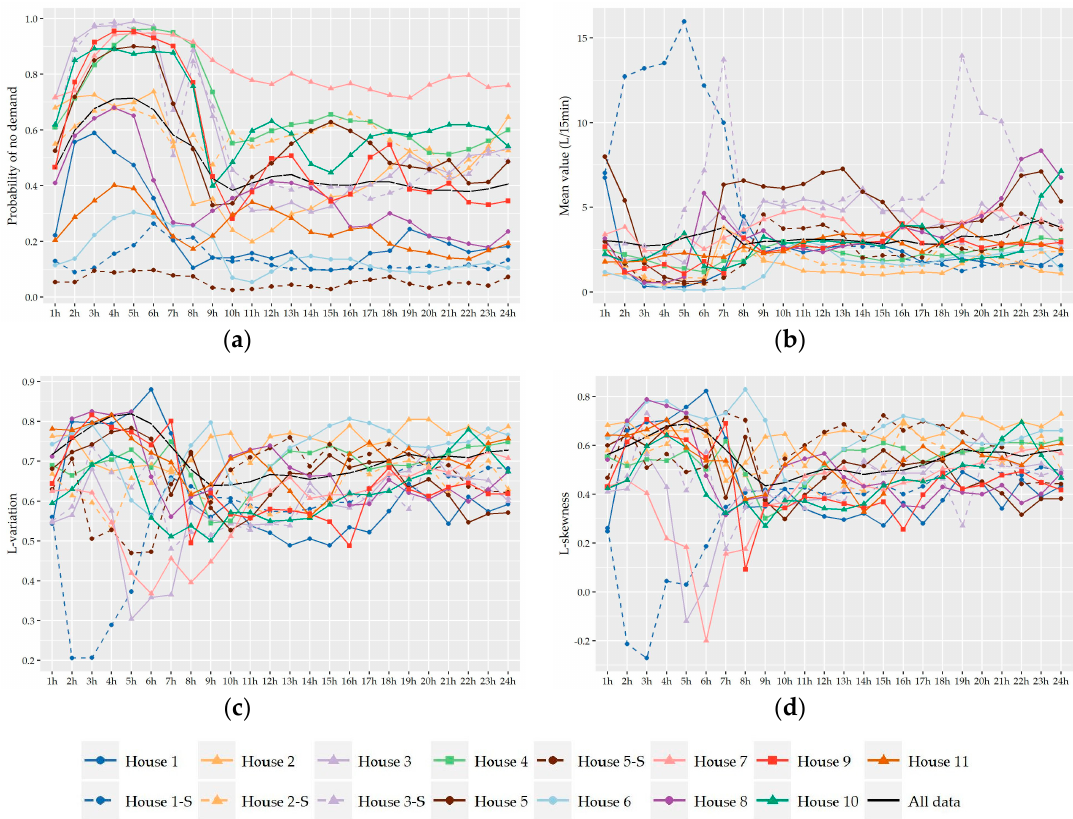
Figure 4. 15-minute scale : Variation per hour of the probability of no demand ( a ), mean value ( b ), L-variation ( c ), and L-skewness ( d ) of the 15-minute nonzero demand records analyzed.